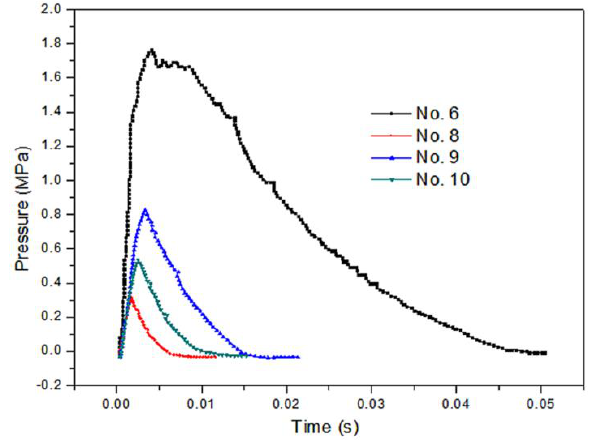
Figure 15. The energy-release phenomenon of the jets at the peak pressure under different schemes.